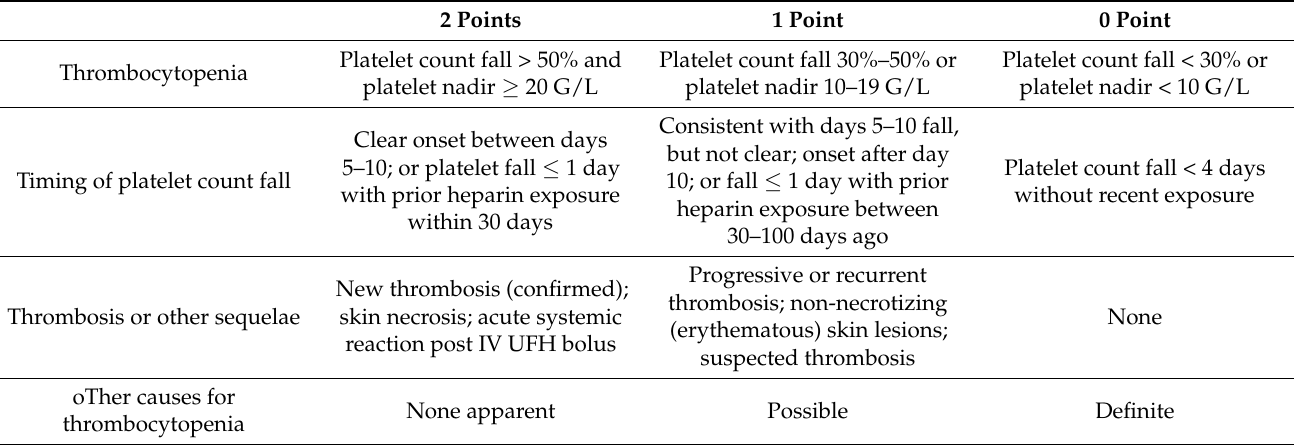
Table 2. 4Ts pretest clinical score of HIT